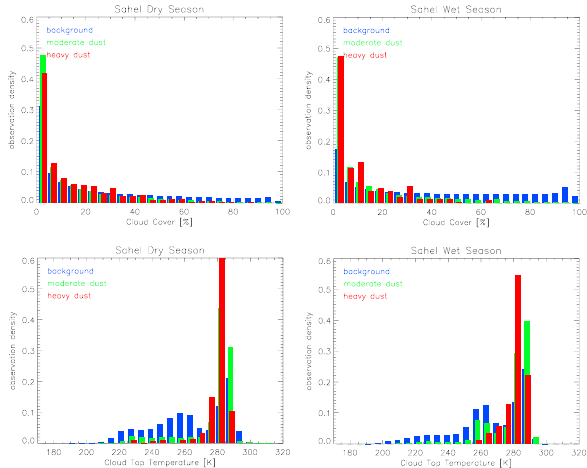
Fig. 7. Histograms of SEVIRI cloud cover (top row) and cloud top temperature (bottom row) observed at 12:00UTC for three BMDI dust classes (colours as in Fig. 3) in the dry and wet seasons (left and right, respectively; dry air masses